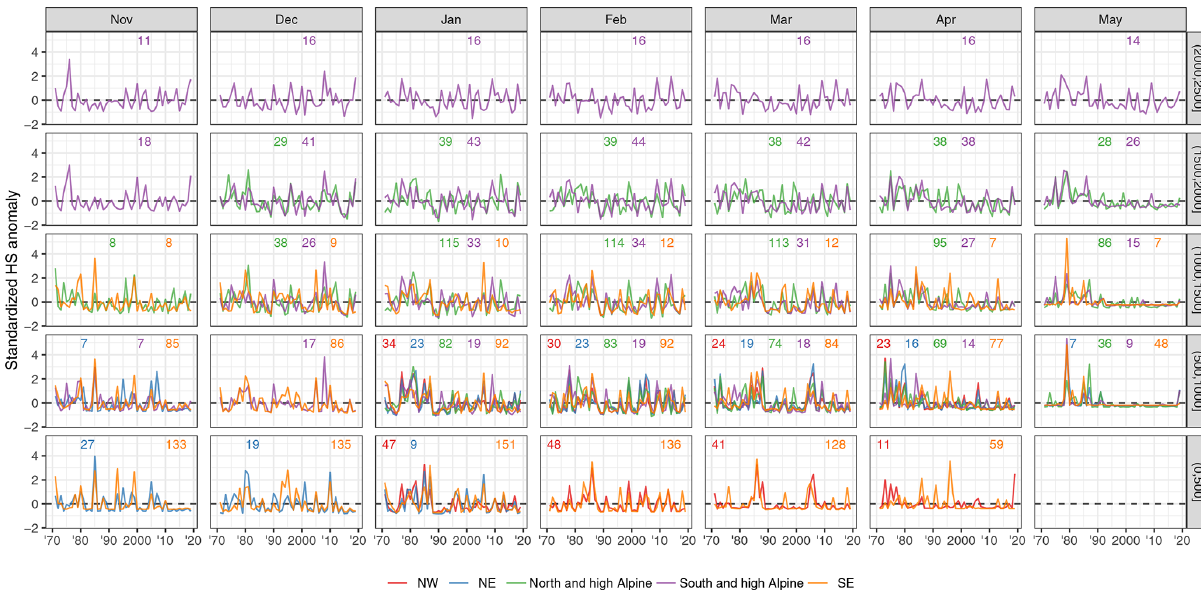
Figure B2. Same as Fig. 8 but using standardized